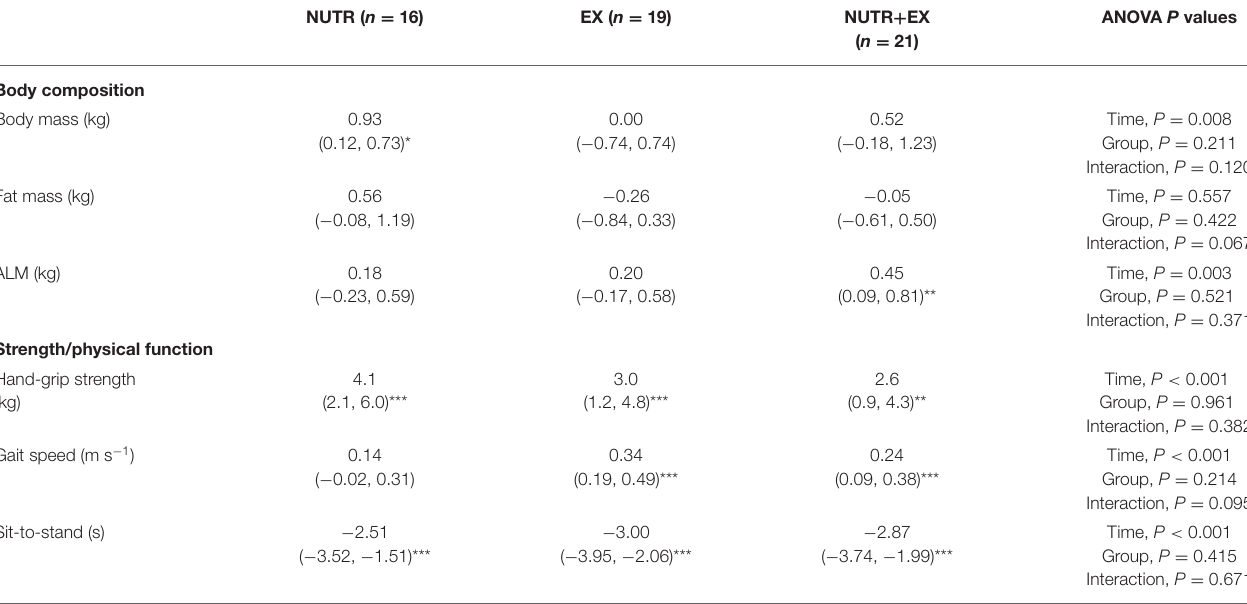
TABLE 3 | Changes from PRE to POST in body composition, strength, and physical function in response to the 12 weeks of concurrent aerobic and resistance exercise training with or without dietary